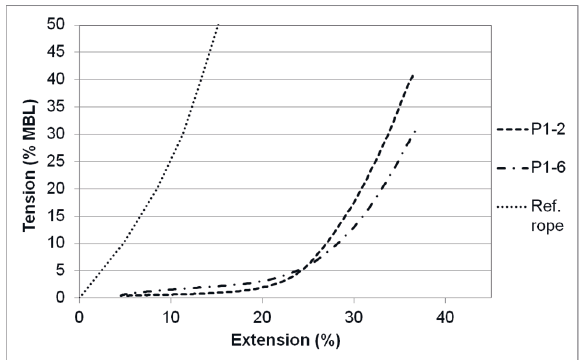
Figure 12. Normalised extension properties of Exeter Tether prototypes shown alongside a double braid polyester reference rope.